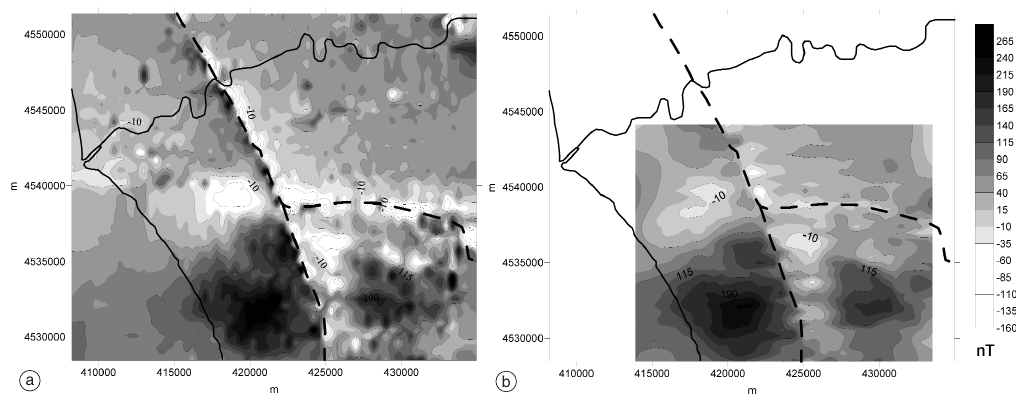
Fig. 3a,b. Aeromagnetic field measured in the new survey. The dashed lines show the railway line. a) Field measured at 70 m above the ground surface. b) Field measured at 400 m above the ground